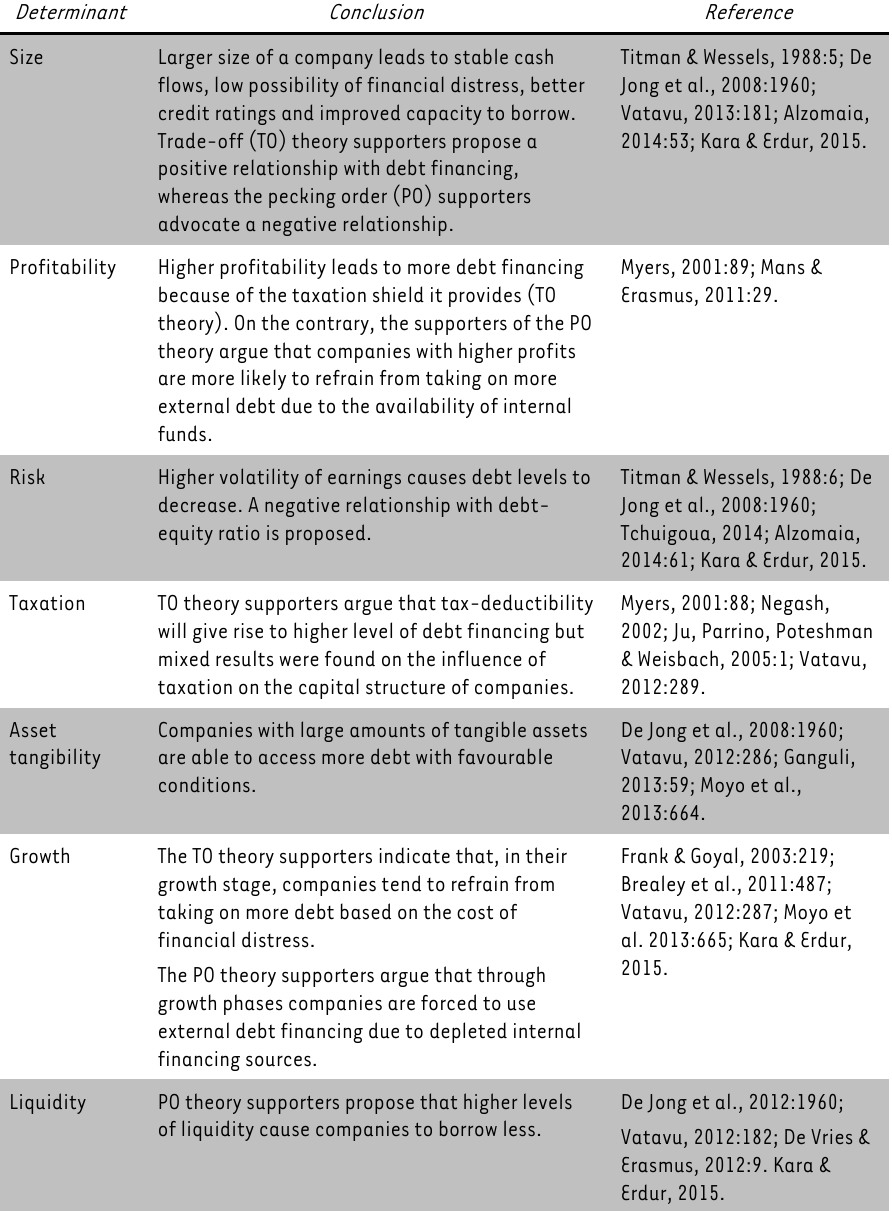
TABLE 1: Company-specific capital structure determinants